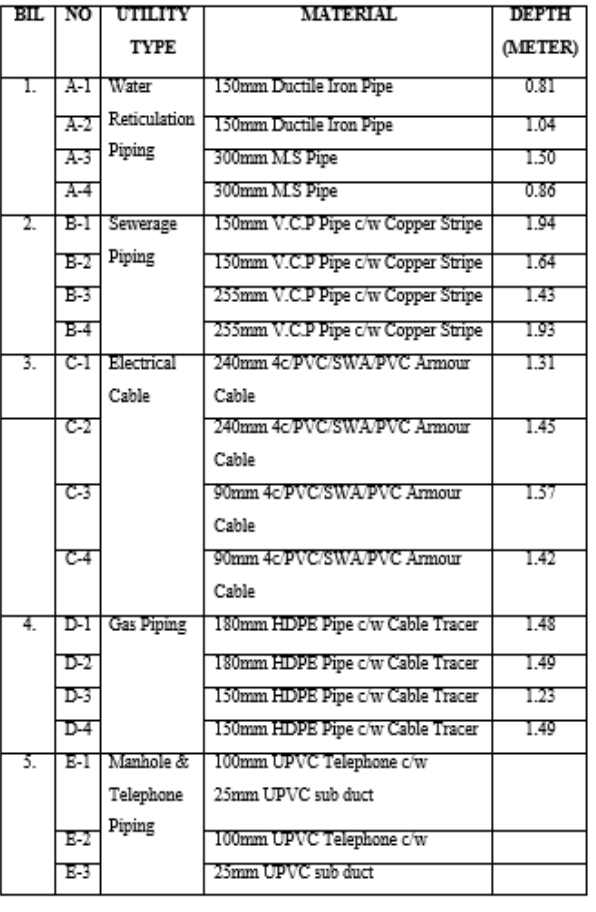
Table 1 . Detail of utility planted at the calibration area